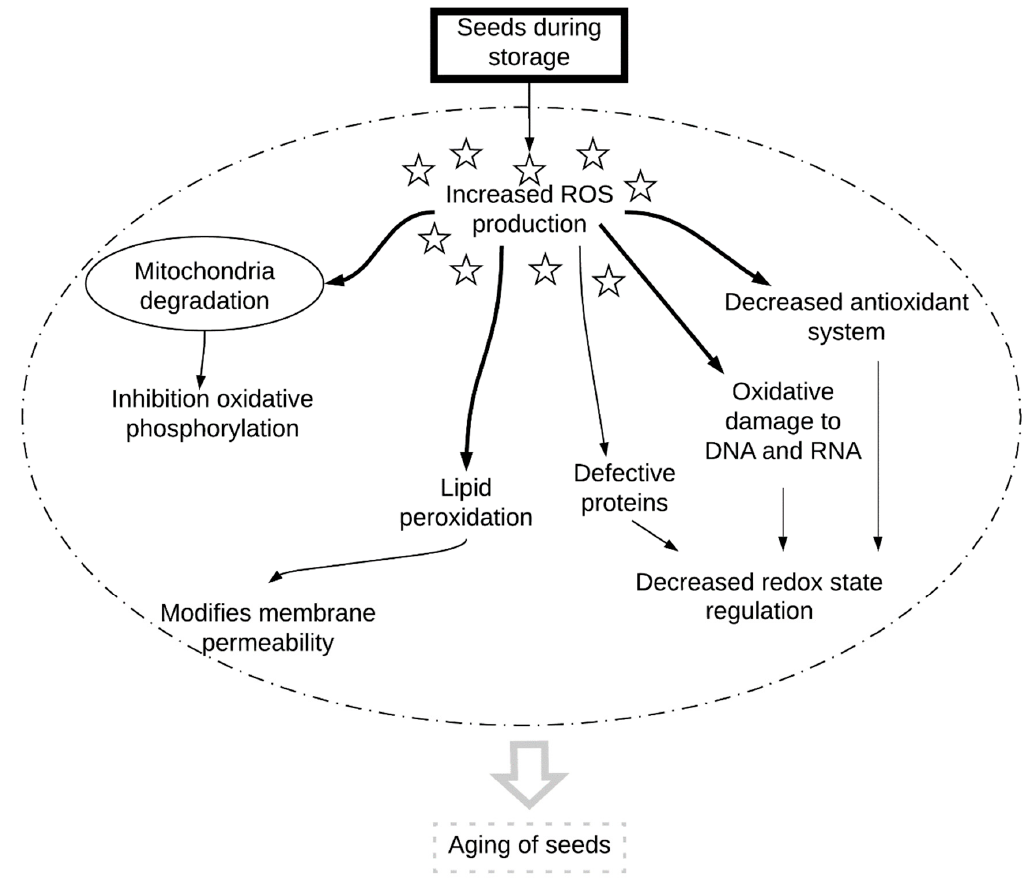
Figure 1. The role of reactive oxygen species (ROS) in seed aging.